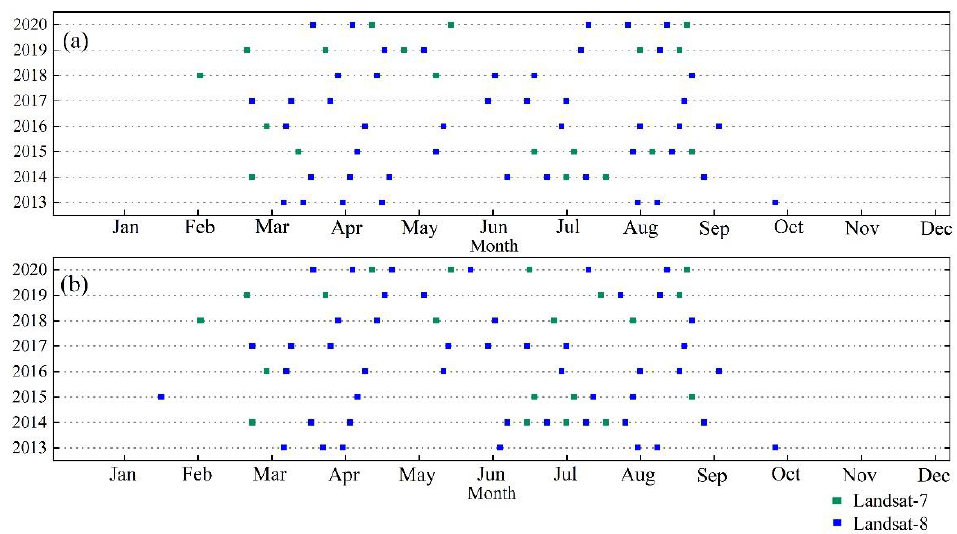
Figure 2. Temporal distribution of Landsat 8 and Landsat 7 images used in this study. ( a ) path/row 23/35; ( b ) path/row 23/36.